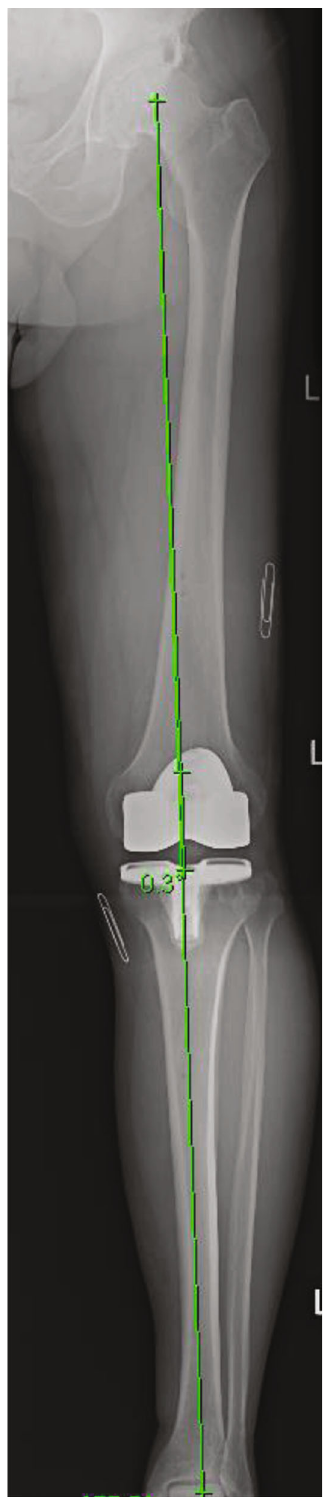
Figure 11: Postoperative long-leg standing radiograph of the left leg for Case 3 showing the corrected neutral mechanical alignment of 0.3 ° varus following